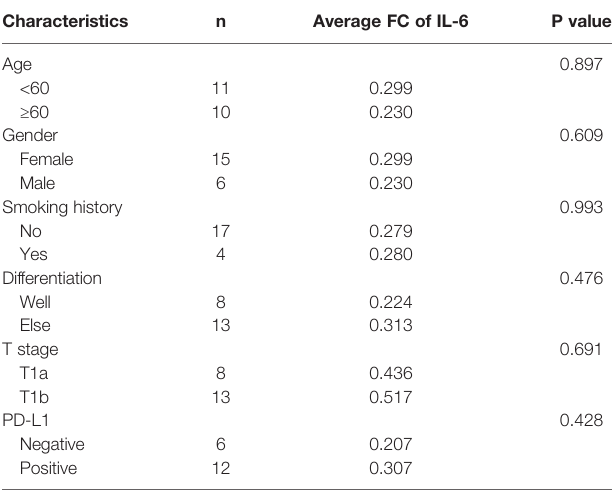
TABLE 1 | The fold change (FC) of IL-6 expression level with main characteristic of the patients in the fl ow cytometry.